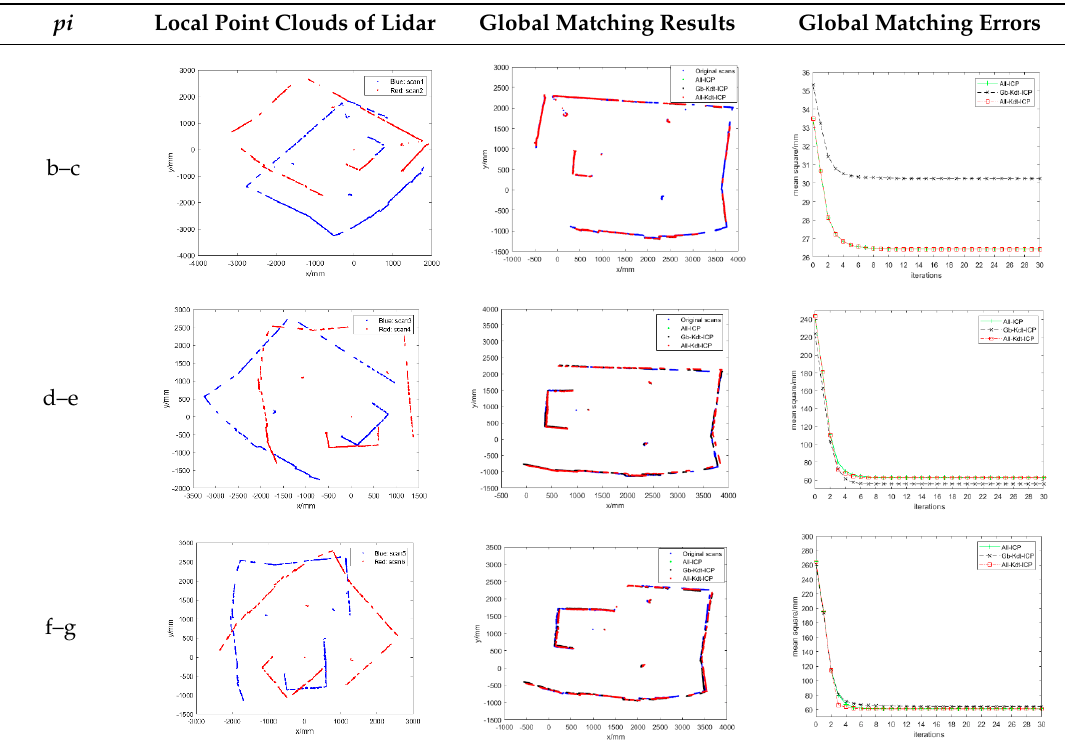
Table 2. Matching of mobile robot between two adjacent